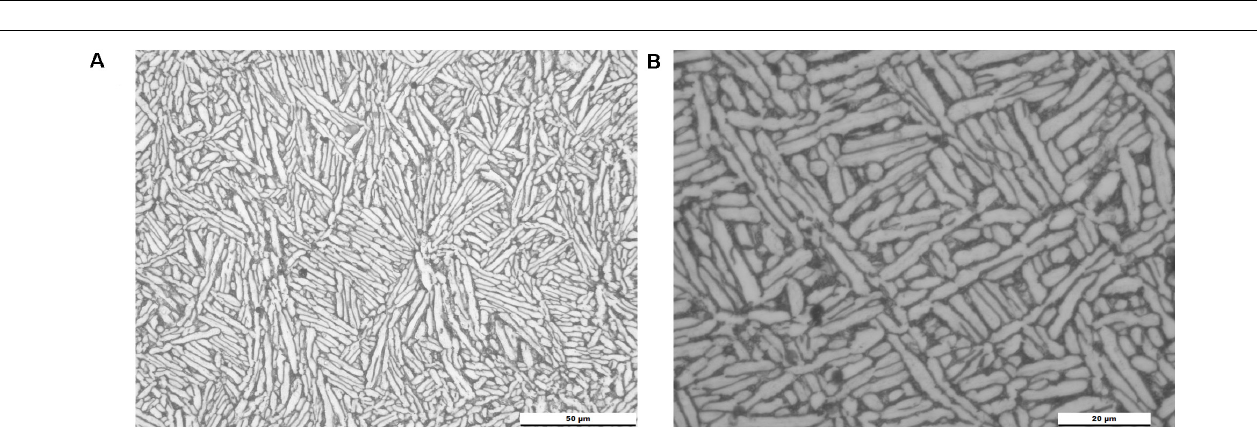
FIGURE 9 | Fracture surfaces of the Ti80 alloys produced with 4 h sintering at: (A) 1200 ◦ C and (B) 1100 ◦ C.